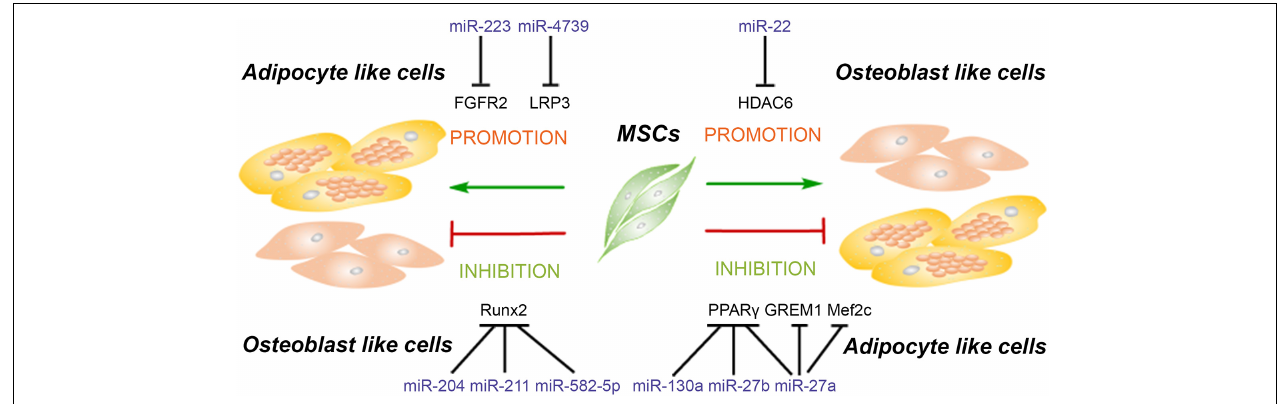
FIGURE 3 | MiRNAs modulate the balance of adipogenesis and osteogenesis of mesenchymal stem cells. MiRNAs promote the adipogenesis and attenuate osteogenesis though targeting Runx2, FGFR2, and LRP3. Meanwhile, some miRNAs enhance the osteogenesis and suppress adipogenesis of MSCs via inhibiting the expression of PPAR γ , GREM1, Mef2c, and